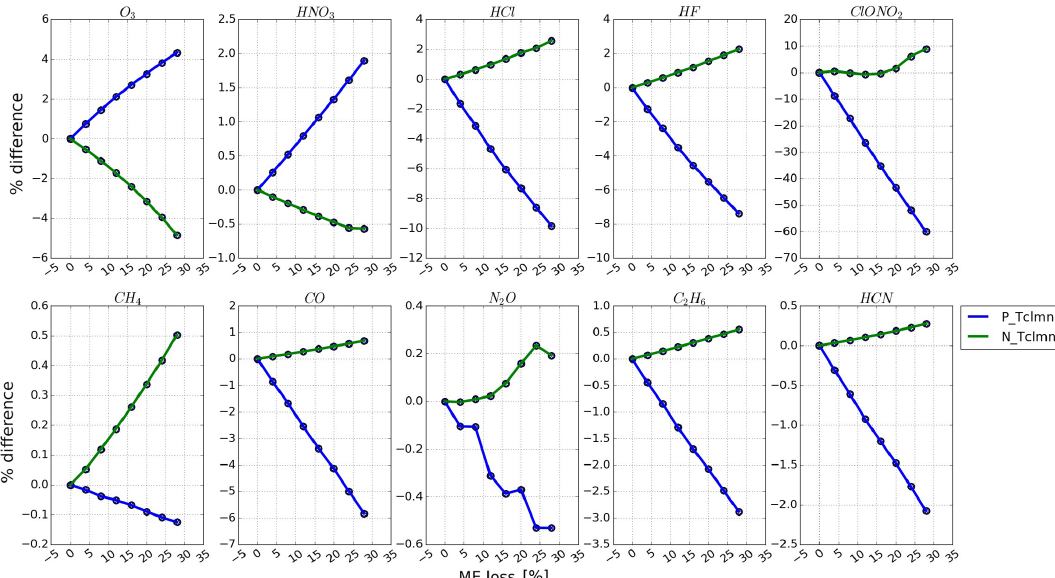
Figure 14. Sensitivity of the total column with respect to ME deviation. “P_Tclmn” represents the sensitivity of the total column with respect to positive ME deviation and “N_Tclmn” represents the sensitivity of the total column with respect to negative ME deviation. The results are deduced from the spectra recorded at Hefei on 16 February 2016.